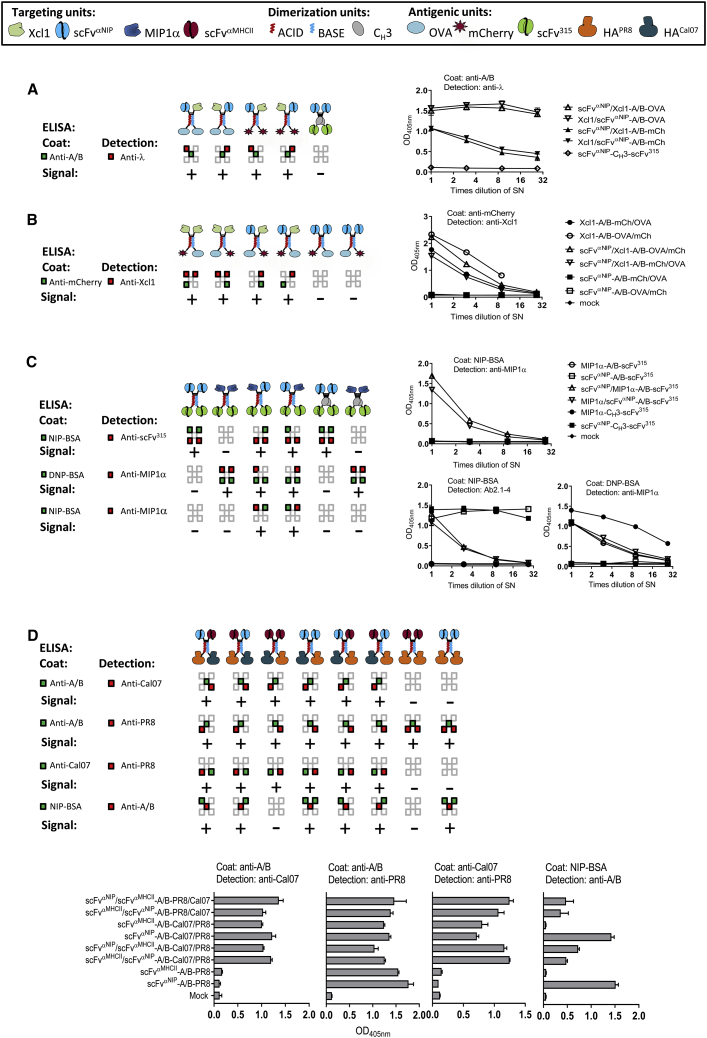
Diverse Targeting Units and Antigenic Units Are Efficiently Expressed on Both the A and B Arm of the Heterodimeric Protein Vaccine In Vitro(A–D) Targeting units, dimerization units, and antigenic units are indicated by symbols (given in boxes). HEK293E cells were transiently transfected with combinations of various DNA vaccine plasmids, theoretically yielding the vaccine molecules depicted in the top rows. Supernatants were analyzed in sandwich ELISAs as indicated (mean + SD). Expected binding of coat mAb (green) or detection mAb (red) to protein vaccine units (squares) is indicated by colors. Positive or negative signal obtained in sandwich ELISAs are indicated by + or −. (A) The targeting units, Xcl1 chemokine and scFvαNIP, were genetically fused to either A or B chains in combination with OVA and mCherry as antigenic units, as indicated. Homodimeric scFvαNIP-CH3-scFv315 was included as a negative control. (B) The targeting units, Xcl1 and scFvαNIP, were genetically fused to either A or B chains in combination with antigenic units OVA and mCherry, as indicated. (C) MIP1α and scFvαNIP were expressed in all possible combinations in the targeting units of A/B heterodimers and CH3-based homodimers, as indicated. The antigenic unit, scFv315, was invariable. (D) The targeting units, scFvαMHCII and scFvαNIP, were expressed with antigenic units HA from PR8 and Cal07 influenza strains in A/B heterodimers, as indicated.